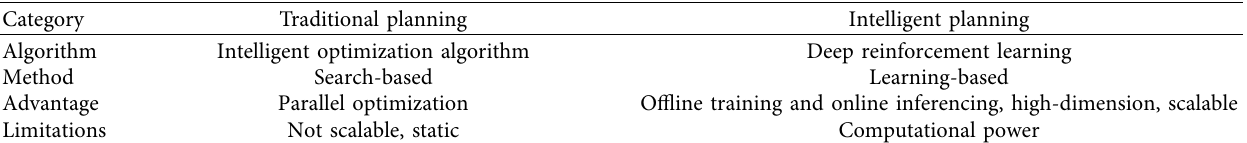
Table 1: Traditional and intelligent planning.